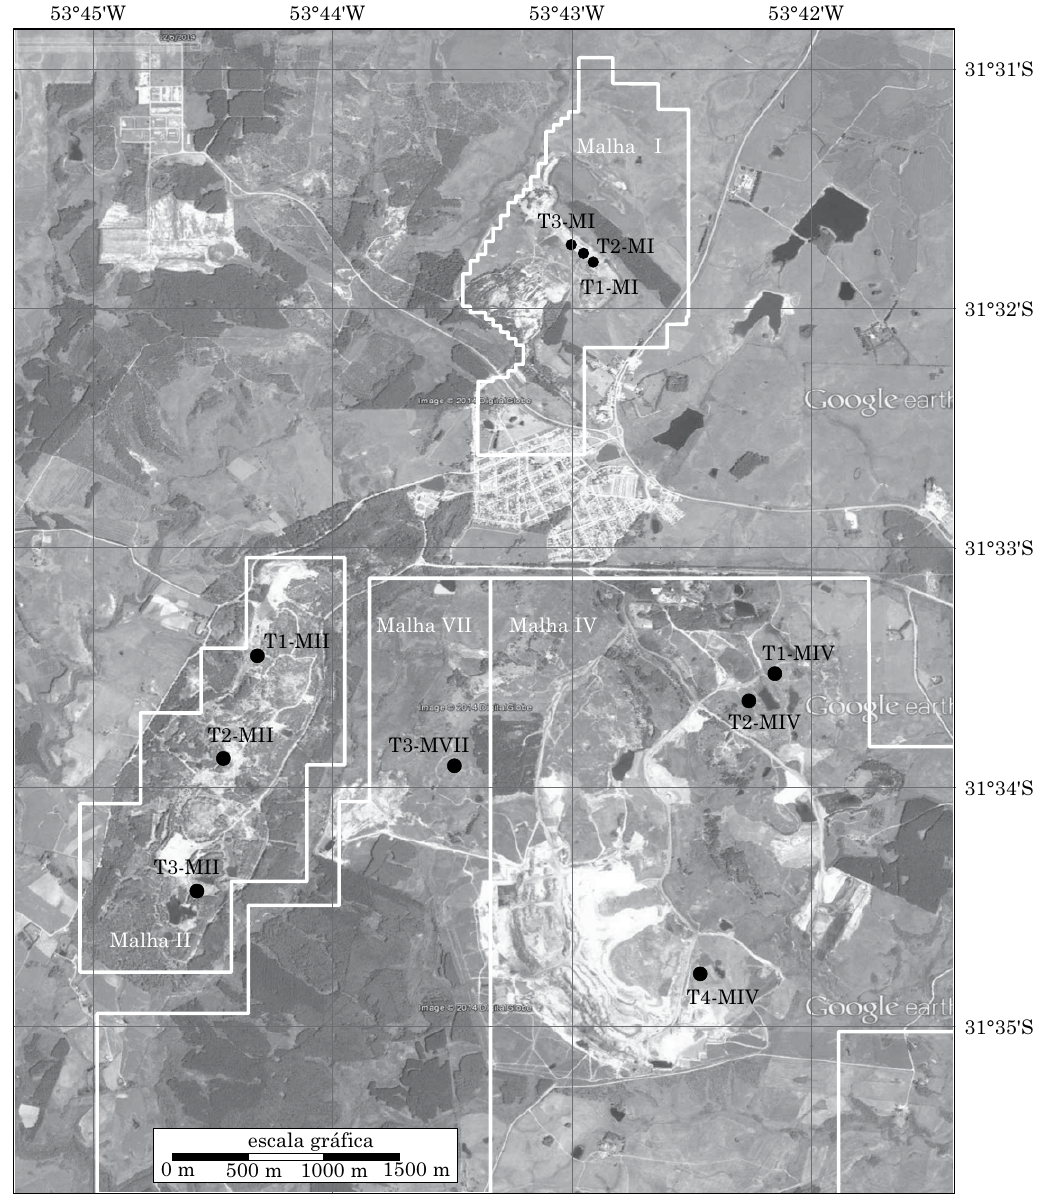
Figura 2. Área de mineração da Companhia rio-grandense de Mineração em Candiota, rS, com as identificações das áreas (malhas) mineradas e das